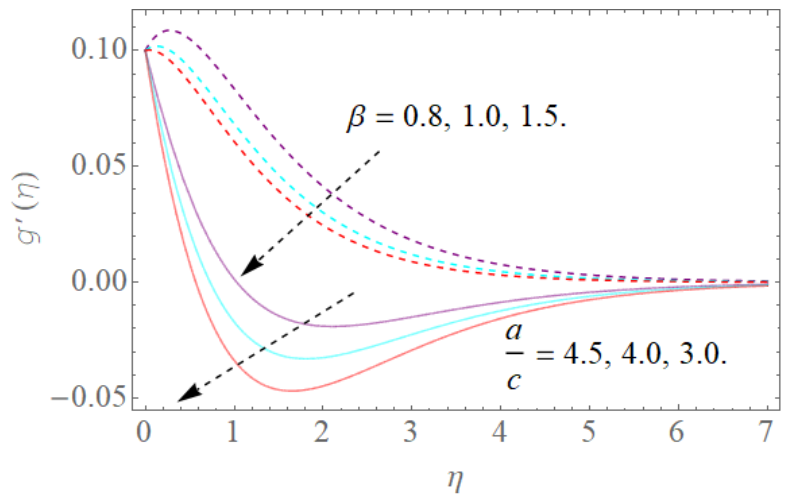
Figure 6. The effect of β , a